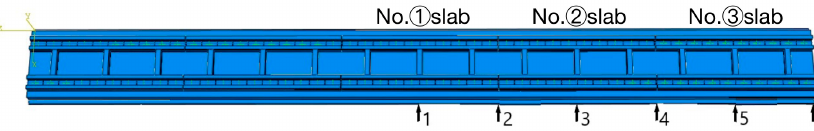
Figure 11. Layout of track slab displacement measuring points.